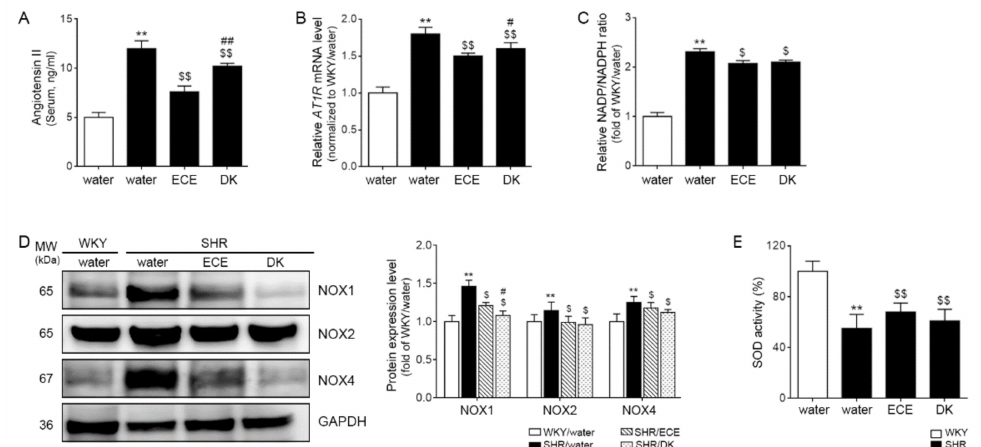
Figure 1. Regulatory effect of ECE and DK on serum Ang II, AT1R, and ROS production in the muscle of SHRs. ( A ) The Ang II level in serum increased following SHR/water and decreased following ECE or DK treatment; ( B ) the expression levels of AT1R mRNA in muscle increased following SHR/water and decreased following ECE or DK treatment. The mRNA levels were measured by qRT-PCR, normalized versus actb , and expressed relative to the WKY/water group levels. ( C ) The NADP + /NADPH ratio in muscle was increased following SHR/water and decreased following ECE or DK treatment. ( D ) The expression levels of protein in ROS production (Nox1, NoxX2, and Nox4) in muscle were increased in SHR/water groups and decreased in ECE- or DK-treated groups via immunoblotting. ( E ) The SOD activity in the muscle decreased following SHR/water and increased following ECE or DK treatment. Data are presented as mean ± SD. For each of